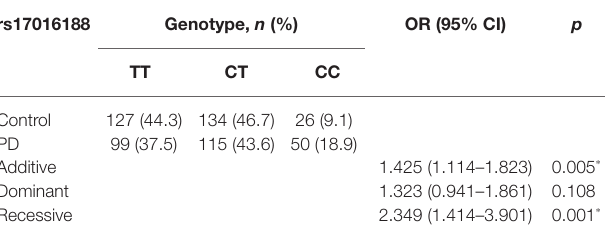
TABLE 3 | Multivariate analysis of rs17016188 in the male PD cases and controls adjusted with age.